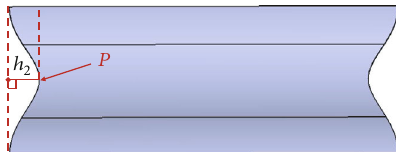
Figure 13: Symmetrical arc structure of